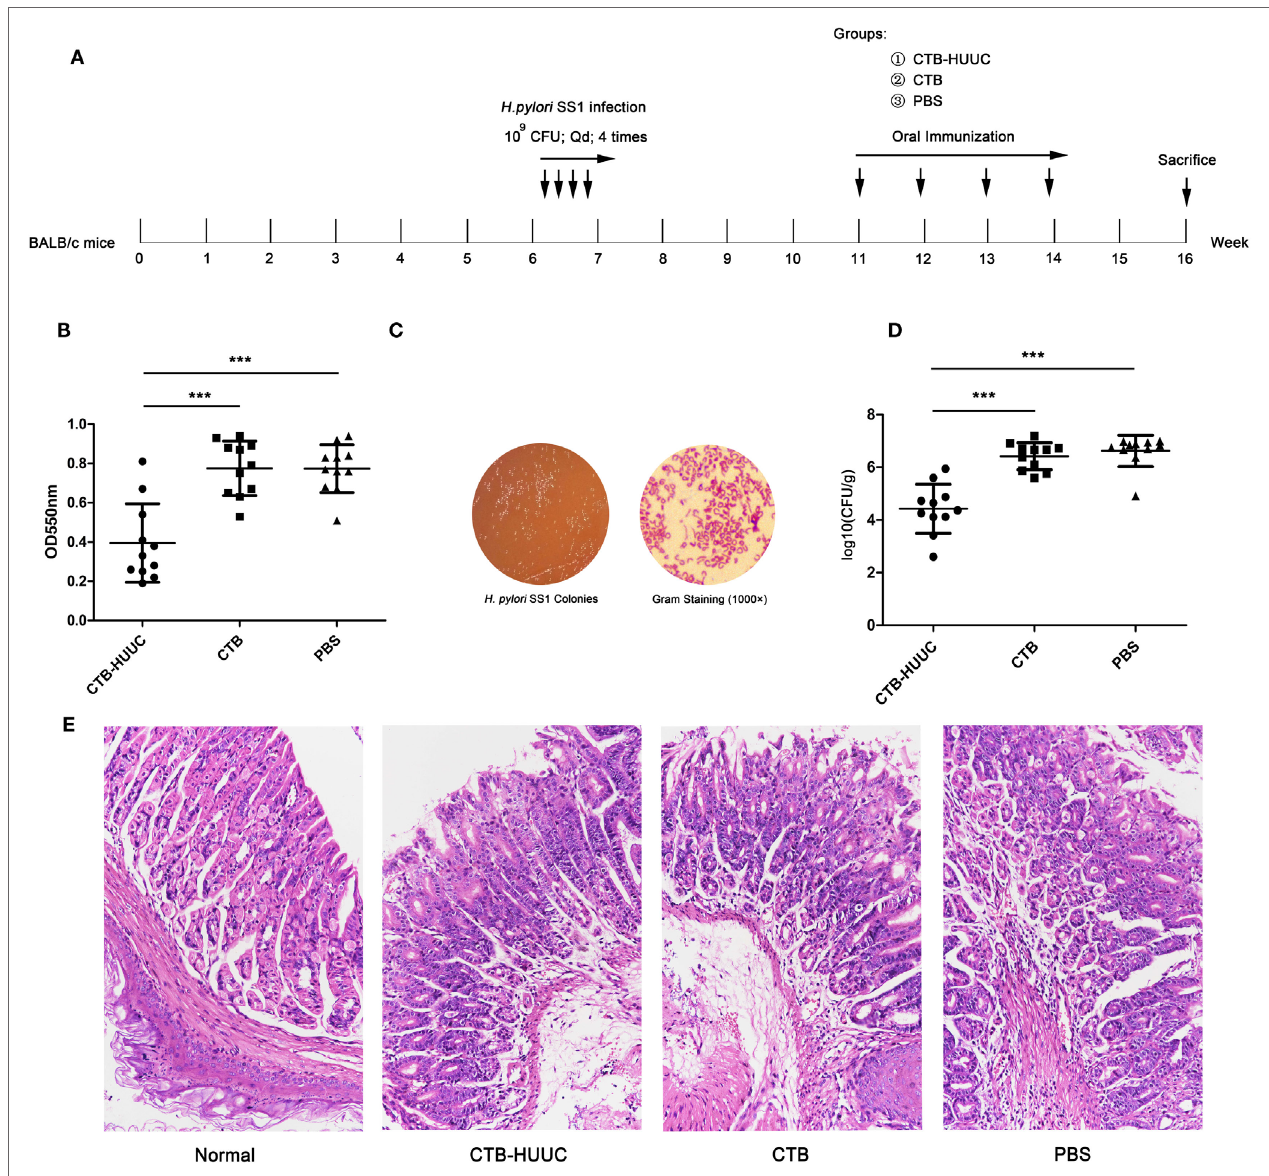
FigUre 6 | The effects of therapeutic vaccination with cholera toxin B subunit (CTB)-HUUC or CTB on H. pylori infection. (a) The therapeutic vaccination procedure. (B) The relative levels of urease activity in the stomach of mice immunized with oral administration of CTB-HUUC or CTB after H. pylori infection. *** p < 0.001, compared with the PBS group or between the CTB-HUUC and CTB groups. (c) Representative view of the H. pylori culture for colony formation assay. (D) The colony-forming units (CFUs) of H. pylori infection in the stomach of mice immunized with oral administration of CTB-HUUC or CTB after H. pylori infection. H. pylori infection was determined using quantitative culture. *** p < 0.001, compared with the PBS group or between the CTB-HUUC and CTB groups. (e) Gastric histological examination of mice immunized with oral administration of CTB-HUUC or CTB after H. pylori infection. The gastric tissue samples stained with hematoxylin and eosin were examined under a microscope (200 ×